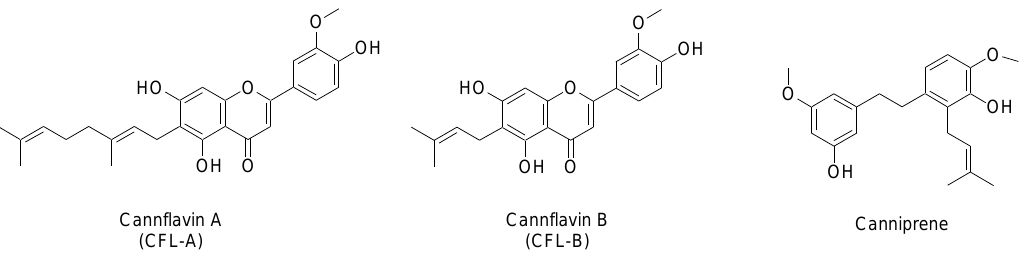
Figure 2. Chemical structures of main flavonoids and related compounds in hemp inflorescences.